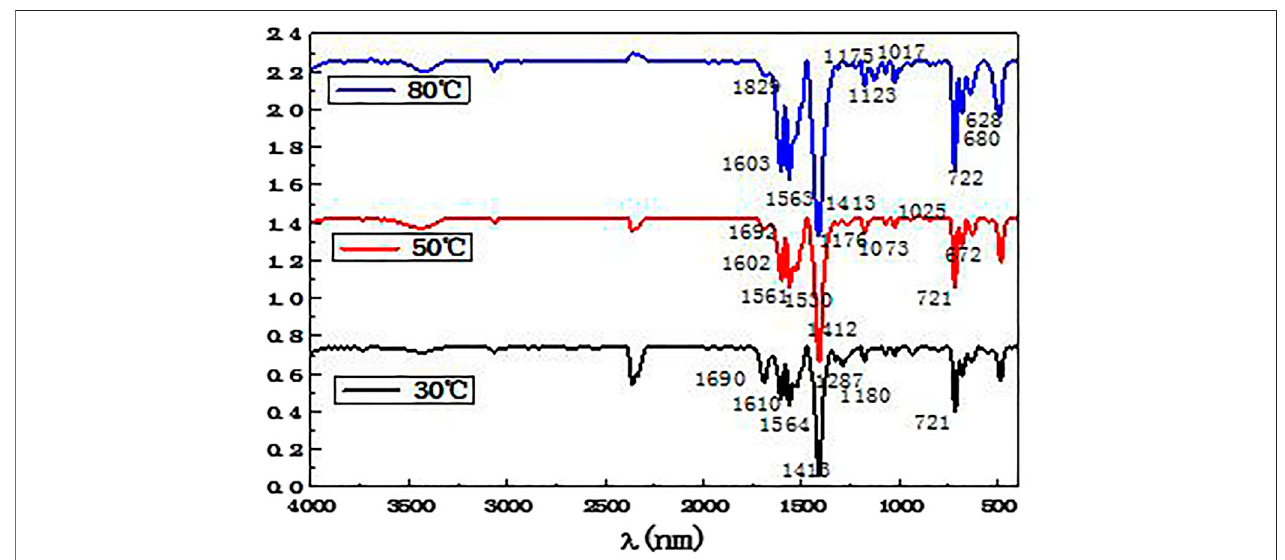
FIGURE 9 | Infrared spectrogram of the product of the benzoic acid and ferrochrome mixed reaction.